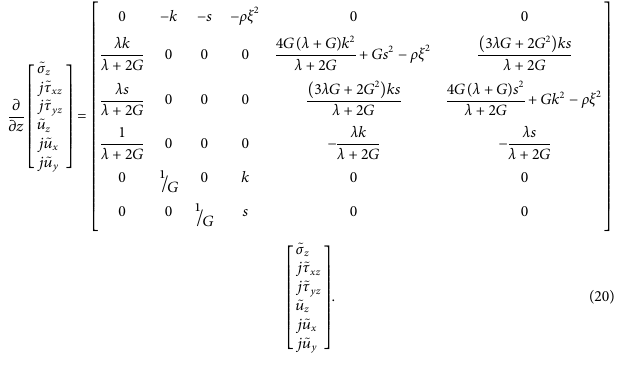
represent the boundary conditionat h = h 1 andsurface,respectively,and h 1 isthelayerthickness. De fi ning T (cid:2) e Bh 1 and combining with the block matrix